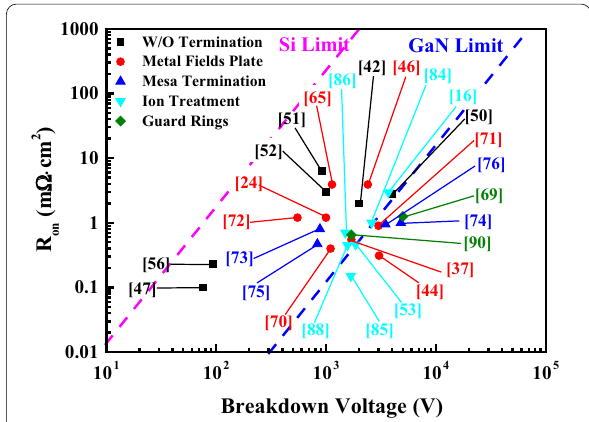
Fig. 11 Benchmarking of the R on versus BV of quasi‑ or full‑vertical GaN